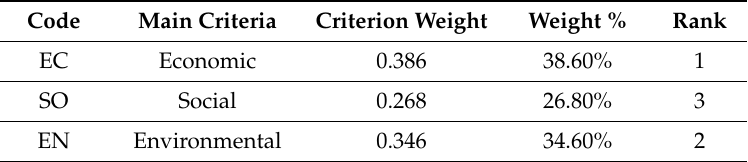
Table 6. Ranking of the green innovation